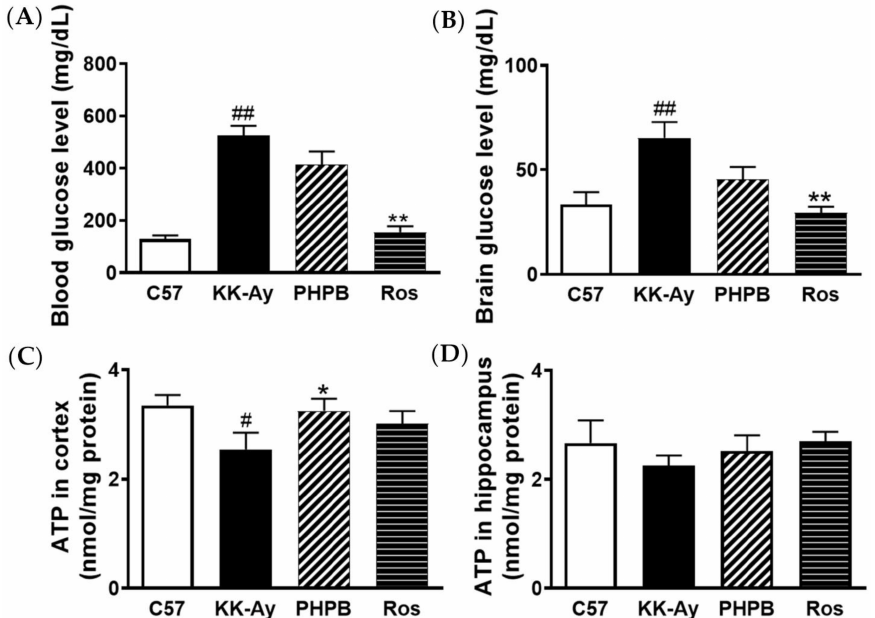
Figure 4. PHPB increased ATP production in the cortex of KK-Ay mice without any obvious differ- ences in glucose levels. ( A,B ) Quantification of blood-glucose and cerebral-glucose using a micro- dialysis method in mice treated with PHPB (150 mg/kg) or rosiglitazone (Ros, 5 mg/kg) for two months, N = 7–10 for each group. ( C,D ) Detection of the ATP contents in the cortex and hippocampus by firefly luciferase method, n = 8 for each group. The data are presented as means ± SEM. # p < 0.05 versus C57 group. # p < 0.05, ## p < 0.01 versus C57 group; * p < 0.05, ** p < 0.01 versus KK-Ay